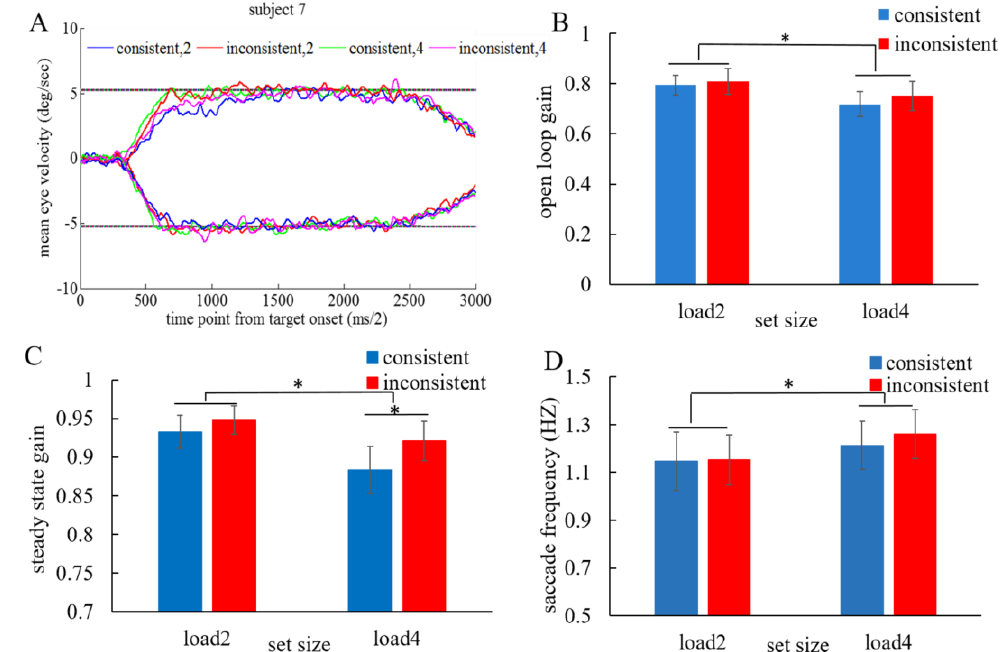
Figure 4. The pursuit performance in the WM + pursuit session. (A) Mean eye velocity trace in all conditions from target onset for a representative subject. The two horizontal line means the target velocity. (B) Peak open loop acceleration for all subjects averaged in the open loop period. (C) Eye velocity gain for all subjects averaged in the steady state. (D) Saccade fre- quency in the retention interval. Error bars represent standard error. Asterisks indicate significance at p <